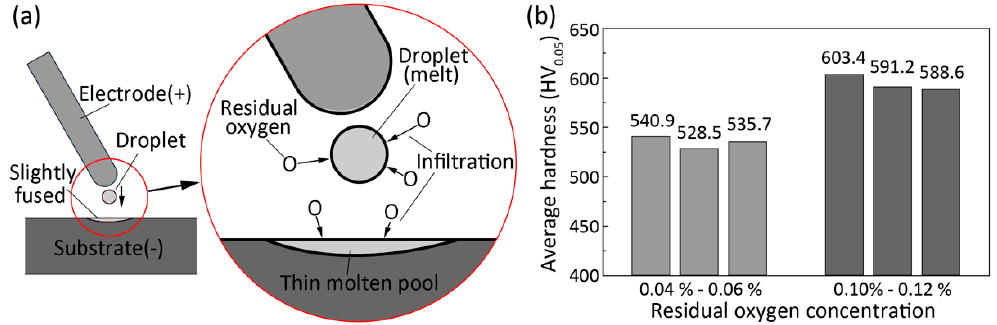
Figure 11. The infiltration of residual oxygen in deposition process ( a ); and the results of contrast testswith different residual oxygen concentration in shielding atmosphere ( b ).